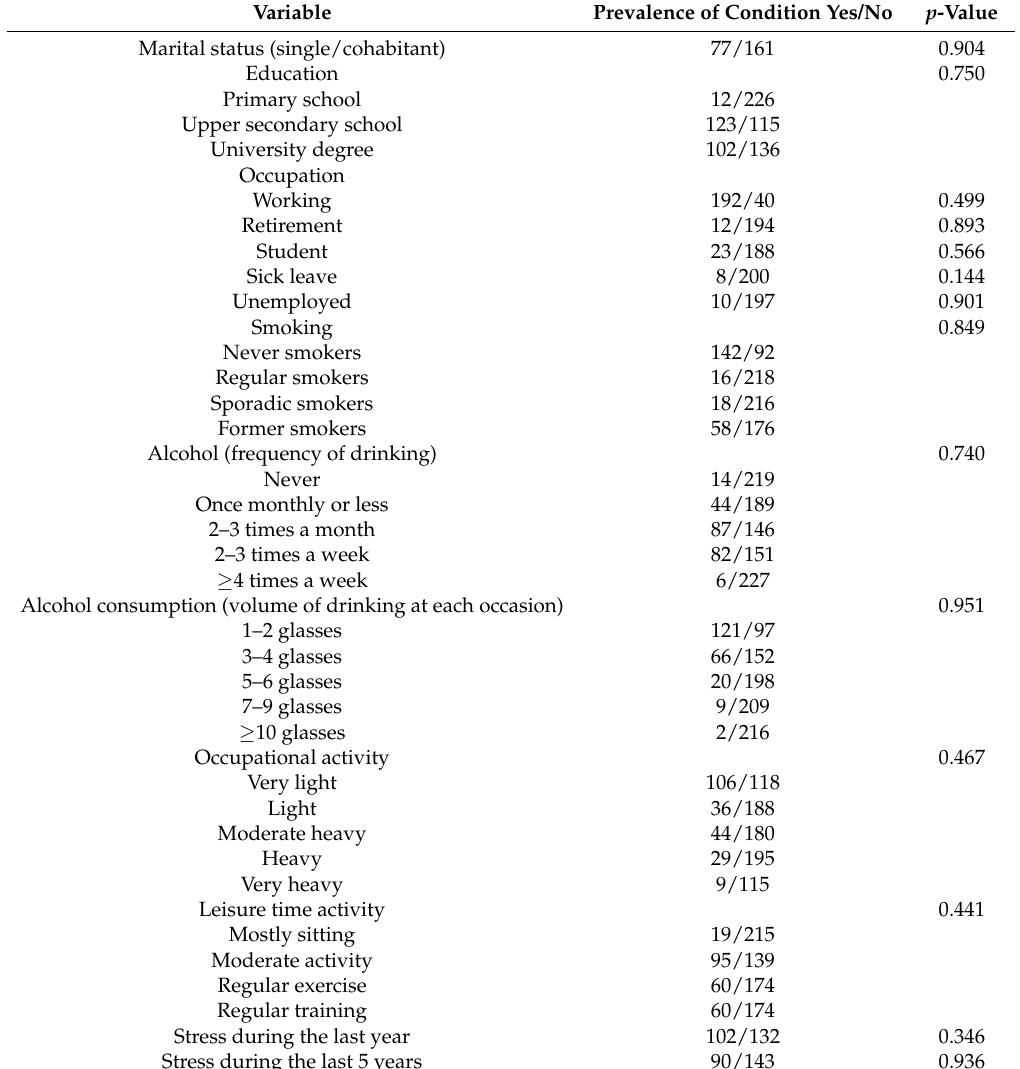
Table 2. Study population